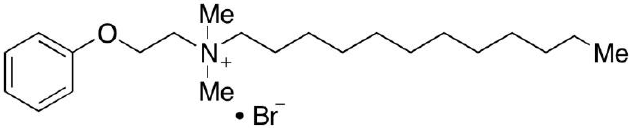
Figure 2. Chemical structure of DB.